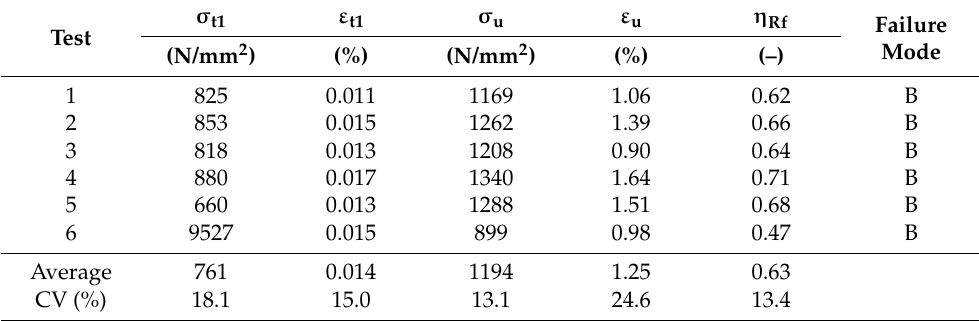
Table 5. B-CTF test results.